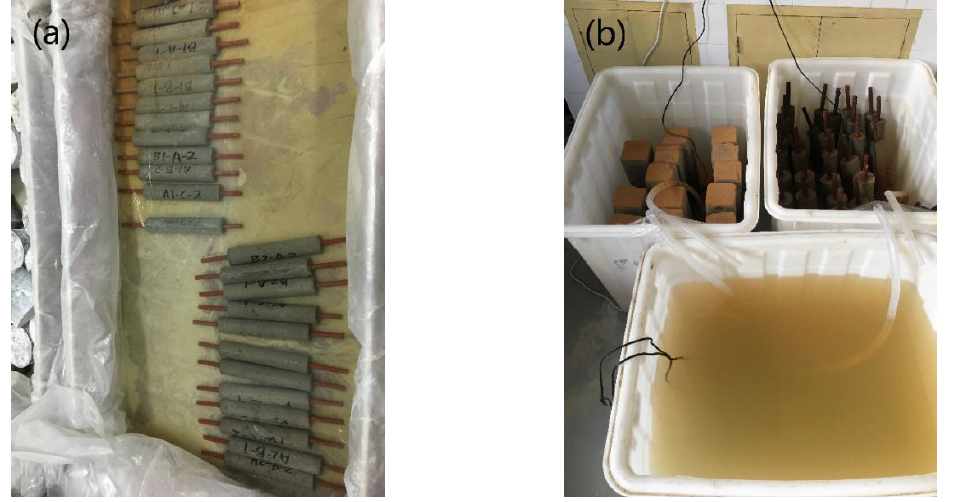
Figure 2. Images of curing setup for test specimens; ( a ) Setup of the immersion process, ( b ) Setup of the wet/dry